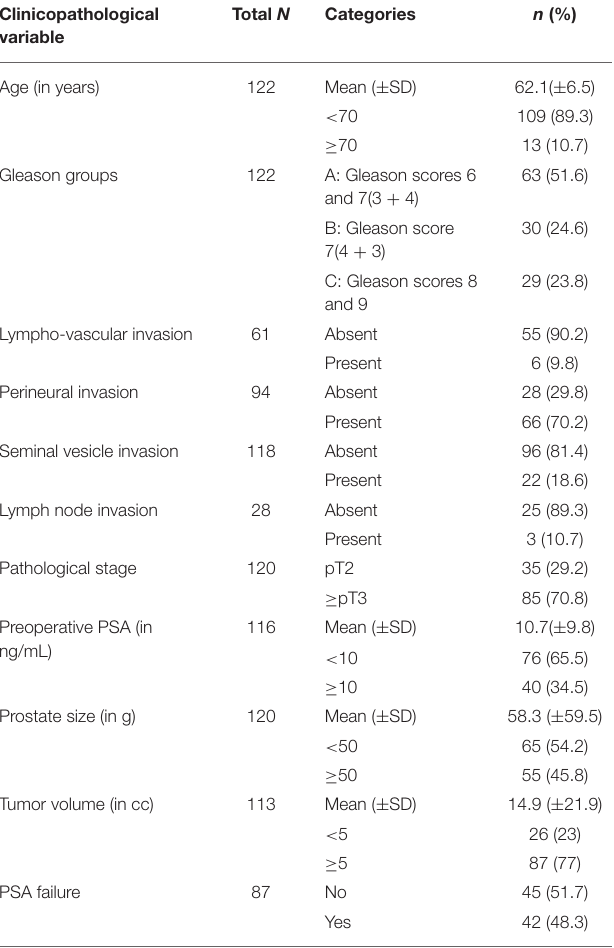
TABLE 1 | Clinicopathological characteristics of the 122 patients with PCa included in our study. Clinicopathological